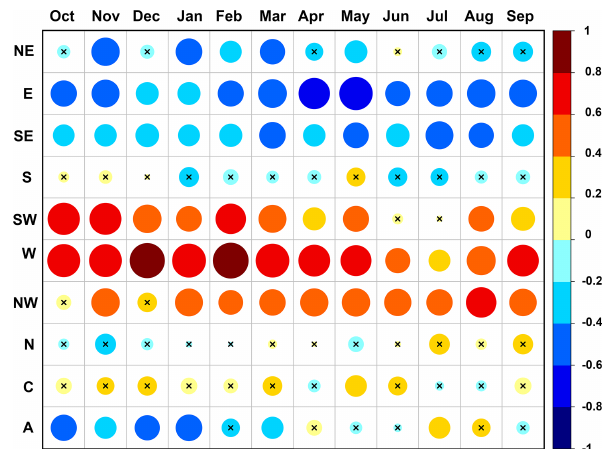
Figure 9. Correlations between the detrended series of the SPEI1 and the monthly percentage of occurrence of each of the pure CWTs for 1980–2017. The size of the circles is proportional to the correla- tion values. The x symbols inside the circles represent statistically non-significant correlations at p < 0 .